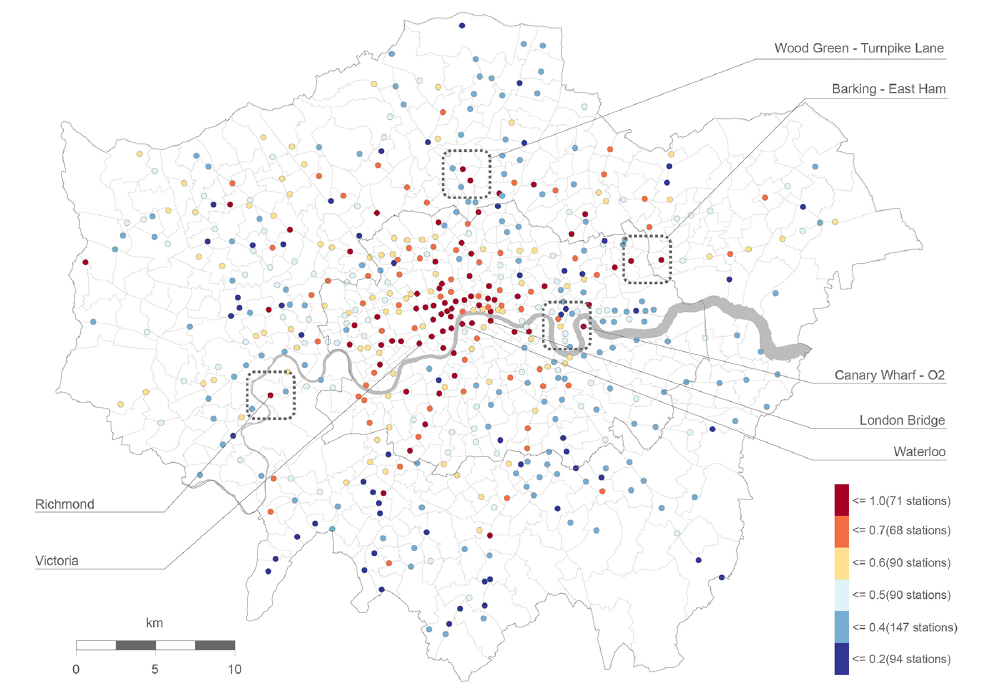
Figure 6: Vitality values for an average week